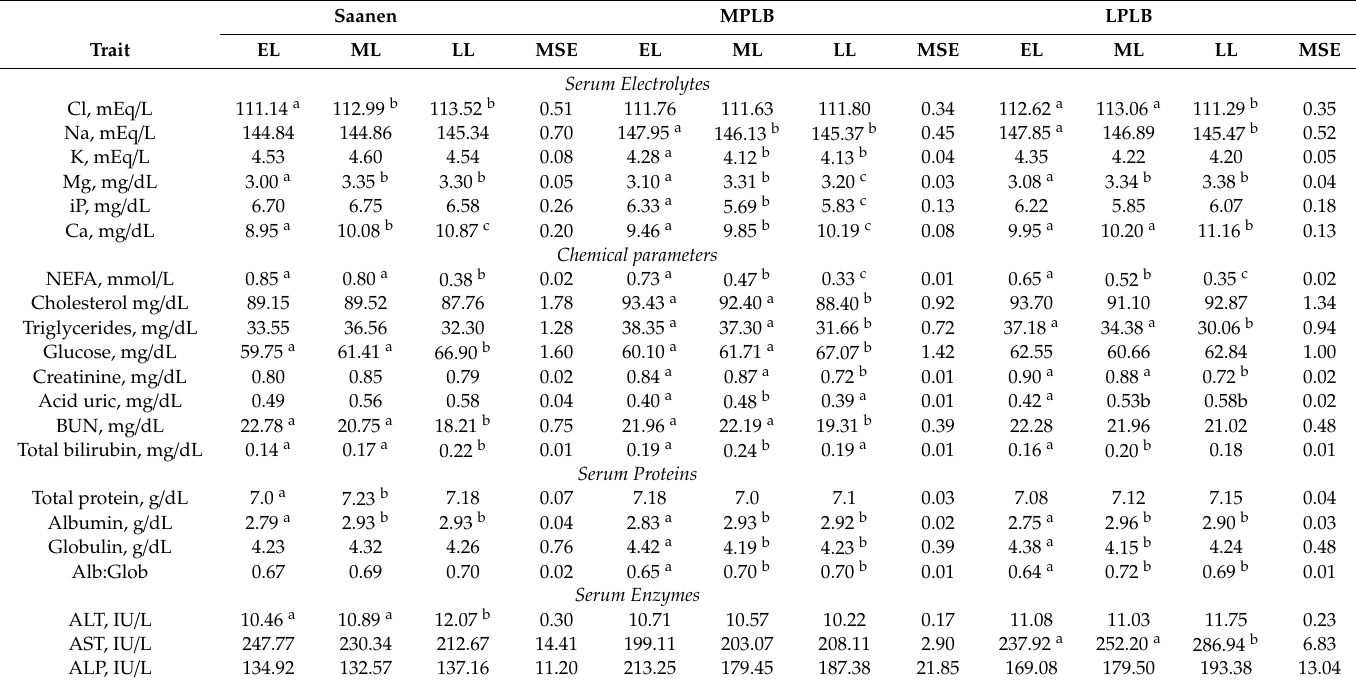
Table 6. E ff ect of the stage of lactation (early lactation, EL, 2–4 weeks in milking; medium lactation, ML, 5–10 weeks in milking; and late lactation, LL, 11–30 weeks) on the plasma mineral and metabolic profile of Saanen breed, Mediterranean medium production level breeds (MPLB: Maltese and Jonica breeds), and low production level breeds (LPLB: Rossa Mediterranea, Girgentana, and Garganica